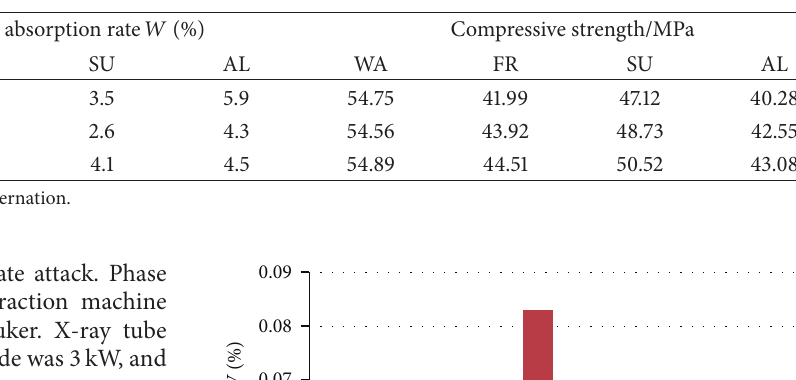
Table 5: Water absorption kinetics parameters of concrete samples.